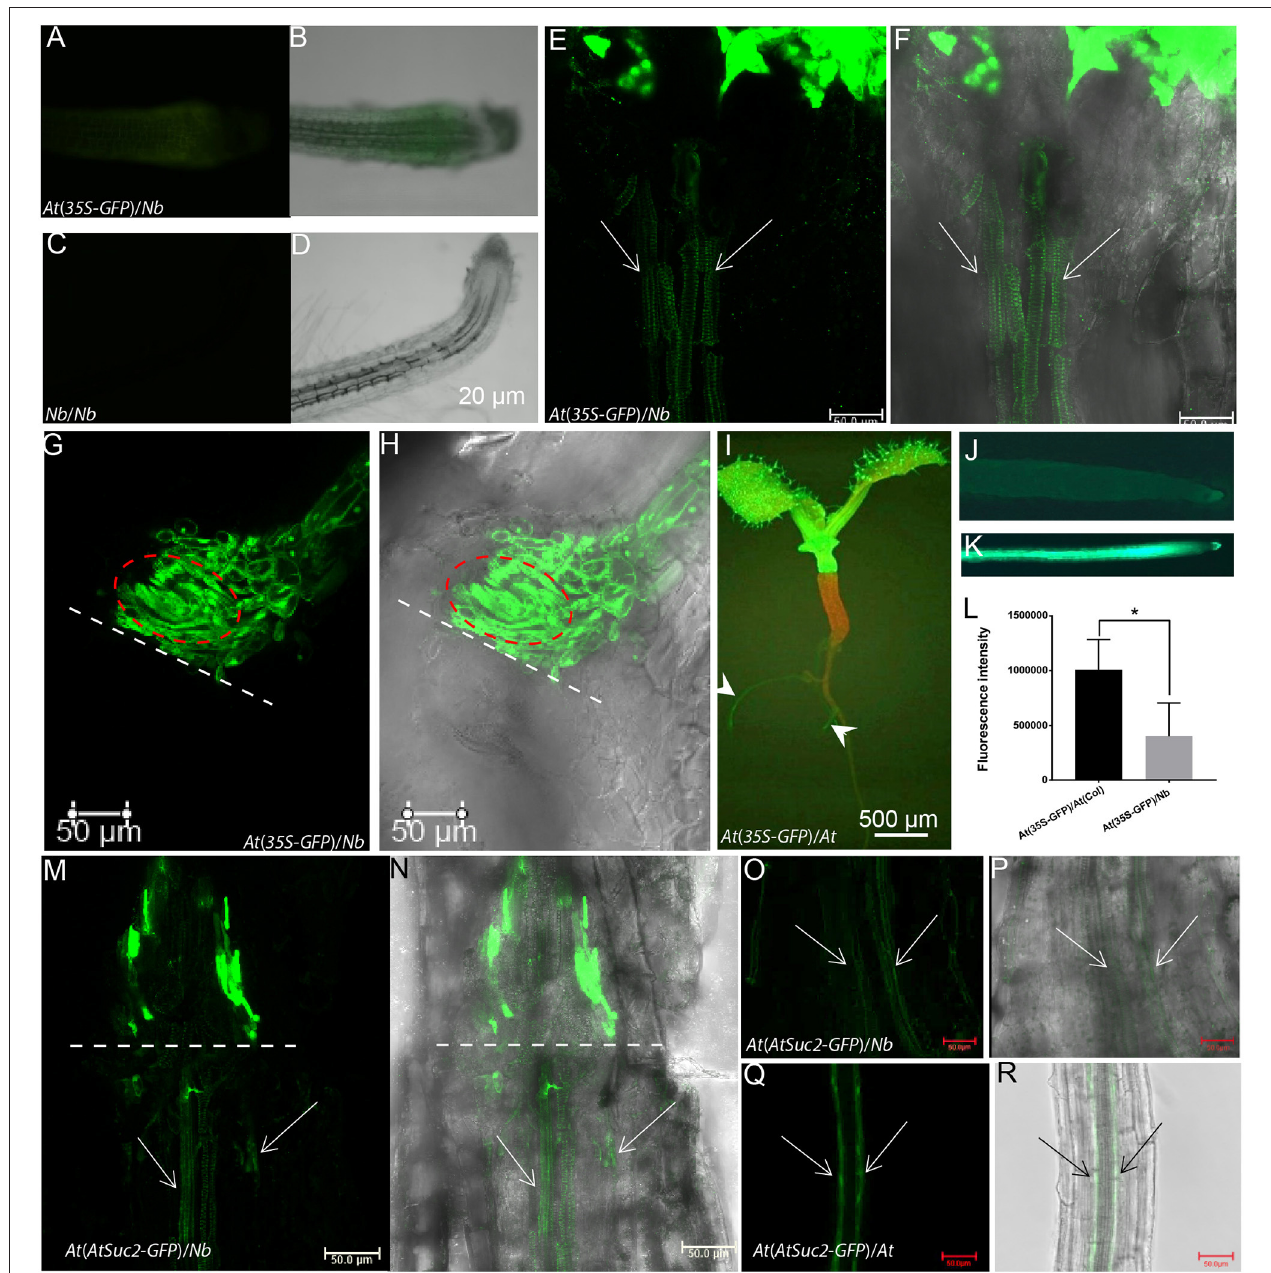
FIGURE 6 | Translocation of GFP from Arabidopsis scion to Nb rootstock. (A,B) The root tip of an At(35S-GFP) / Nb graft at 15 DAG under fluorescence (A) and bright field ( B , overlayed with A ). (C,D) The root tip of Nb self-graft used as control. (E,F) GFP fluorescence was detected below the union of At(35S-GFP) / Nb growth-active grafts at 17 DAG with a Leica SP8 confocal microscope. The overlay image of a bright-field and green fluorescent (false color) channel was shown in (F) . The arrow indicated the GFP signal in the vascular bundles. (G,H) GFP fluorescence was restricted above the union of At(35S-GFP) / Nb quiescent grafts at 17 DAG. The bright-field and fluorescent overlay image was shown in (H) . The dotted line indicated the contacting interface. The circled area indicated the spiraling TEs. (I) An At(35S-GFP) / At (WT) self-graft at 7 DAG. The arrowhead indicated the GFP signal. (J–L) The GFP fluorescence comparison between At(35S-GFP) / Nb (J) and At(35S-GFP) / At (WT) graft (K) . (L) Comparison between fluorescence intensity of the rootstock of At(35S-GFP) / Nb and that of the At(35S-GFP) / At (WT) graft ( p < 0.05). (M,N) The phloem-specific GFP fluorescence was detected below the union of At ( AtSuc2-GFP )/ Nb growth-active grafts at 25 DAG. (N) is the overlay image. (O,P) The GFP fluorescence was detected in the root phloem strands of growth-active At ( AtSuc2-GFP )/ Nb grafts. The arrows indicated the phloem strands of an Nb root. (P) is the overlay image. (Q,R) The GFP fluorescence was strongly detected in the root phloem strands of At ( AtSuc2-GFP )/ At self-graft. (R) is the overlay image. * p < 0.05.